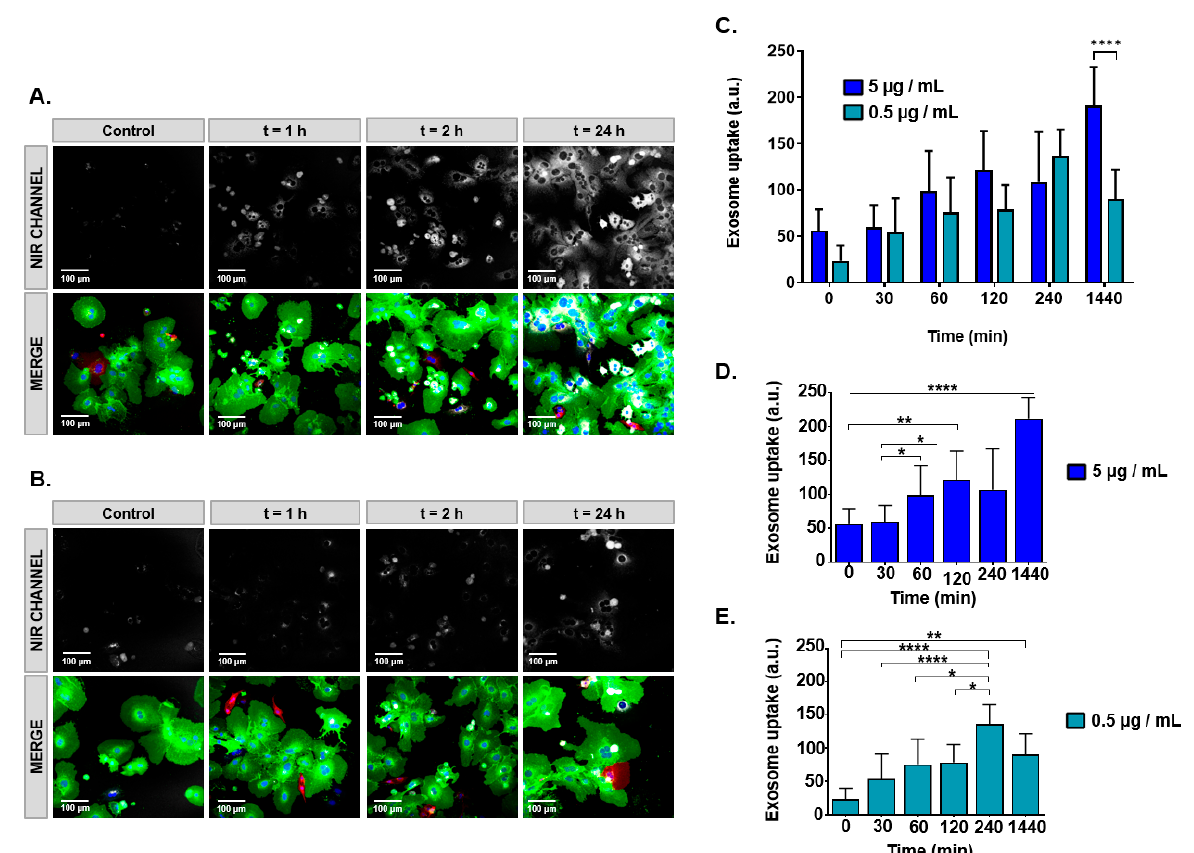
Figure 4. Confocal microscope imaging for assessing the uptake of sulfo-cyanine 7.5-labeled milk exosomes (SCy-MiExo) by hepatocytes. ( A , B ) Near infrared (NIR, top) and fluorescence images (bottom) taken over time as hepatocytes internalized: ( A ) 5 µg/mL and ( B ); 0.5 µg/mL of SCy-MiExo; ( C ) Quantification of the exosome uptake at different SCy-MiExo concentrations, analyzed in regions of interest. Values were statistically significant between both concentration at 24 h; ****( p ≤ 0.0001). Data are expressed as the mean ± standard deviation. ( D ) Statistical analysis for the dose of 5 µg/mL: all values were significant compare to 24 h; *( p ≤ 0.05), **( p ≤ 0.01), ***( p ≤ 0.001), ****( p ≤ 0.0001). ( E ) Statistical analysis for the dose of 0.5 µg/mL; *( p ≤ 0.05), **( p ≤ 0.01), ***( p ≤ 0.001), ****( p ≤ 0.0001).